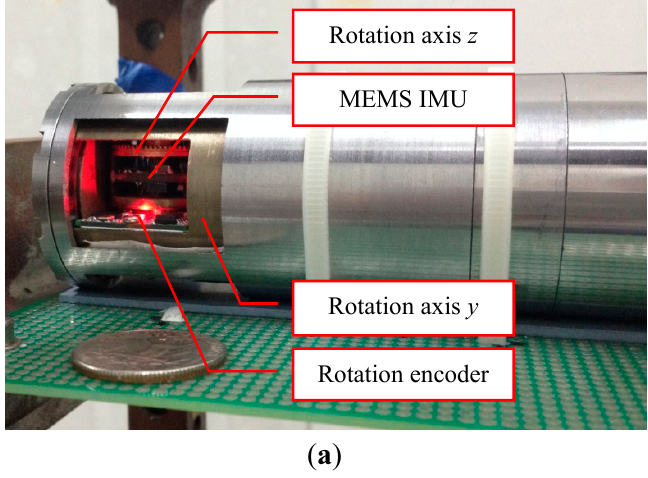
Figure 1. ( a ) Micro-Electro-Mechanical System (MEMS) inertial sensor based Attitude Heading Reference System (AHRS); ( b ) Size of the AHRS compared with a quarter dollar